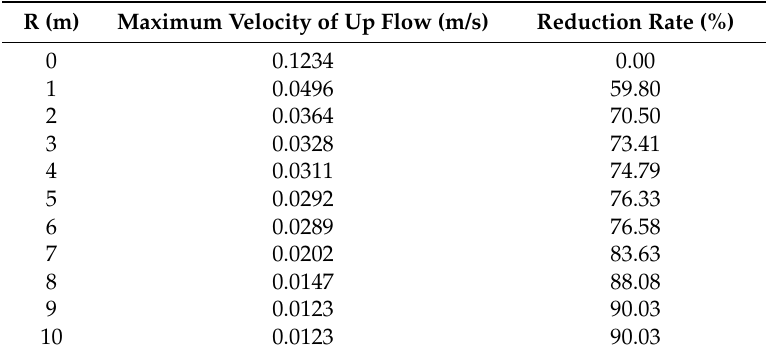
Table 3. Reduction rates of the maximum velocity of up-flow at different values of R . R